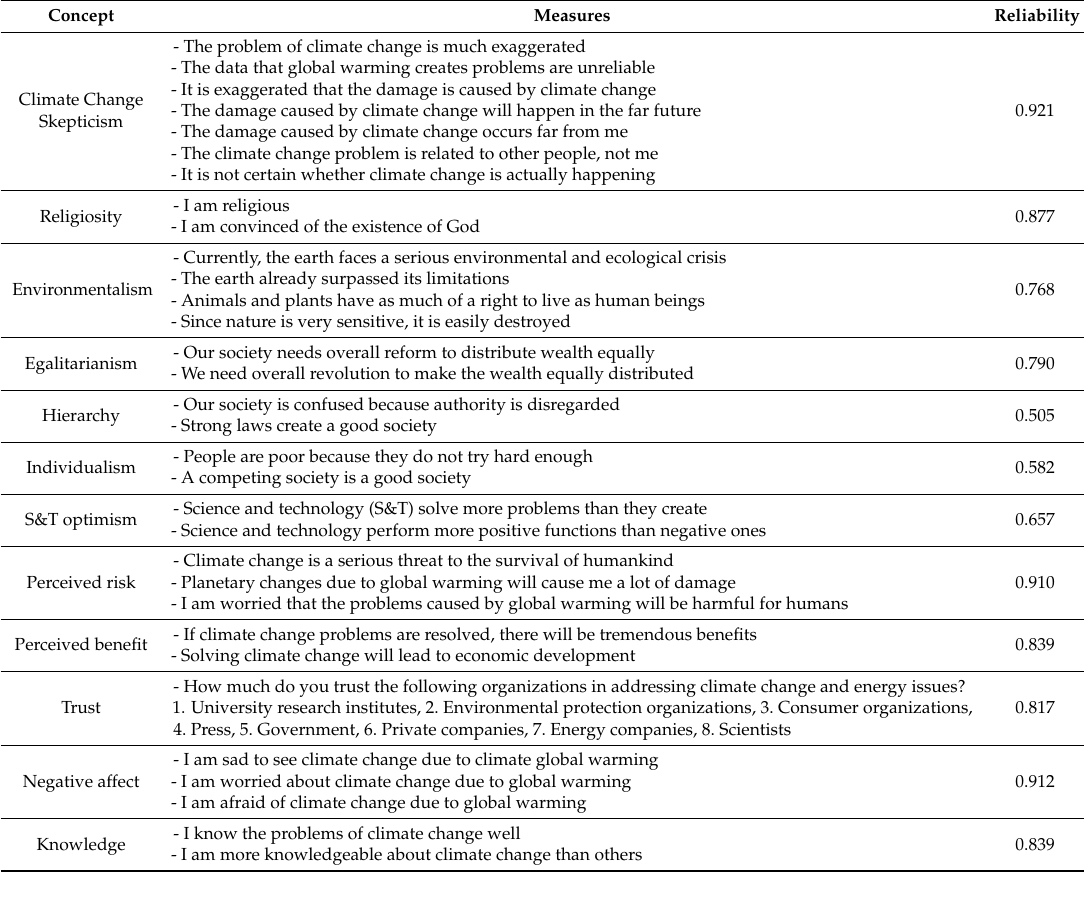
Table 1. Concepts, measures, and reliability.